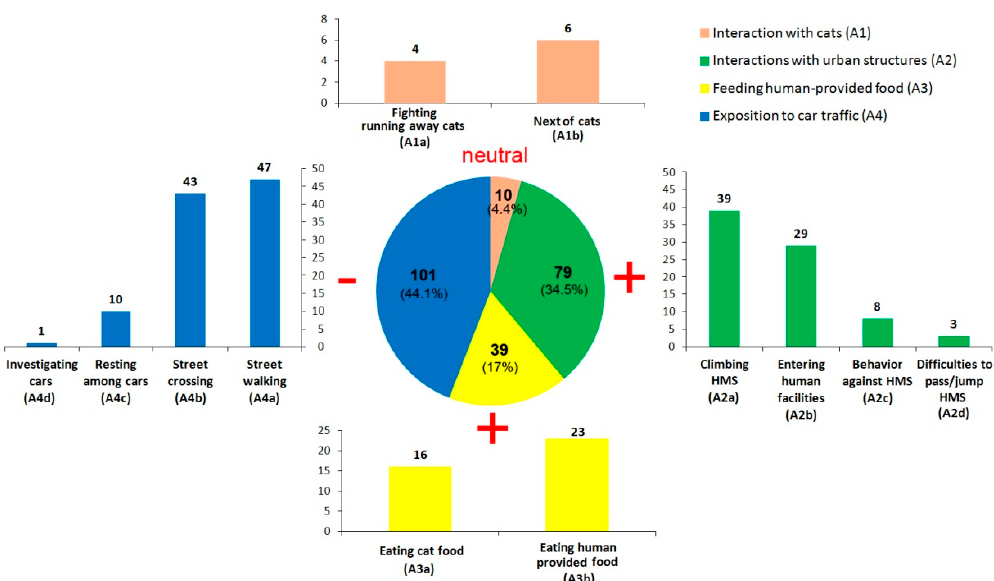
Figure 4. Quantification of the behavior of the Red-legged Seriema related to anthropogenic factors that were observed in the urban area of the “Luiz de Queiroz” campus. In all graphs, the Y -axis displays the absolute number of each behavior. The signs show whether general behaviors are helping ( + ) or harming ( − ) the Seriemas to adapt to urbanized zones. Some behaviors are considered neutral. Acronyms are: HMS = human-made structure. For a detailed description of each behavior see Table 1.